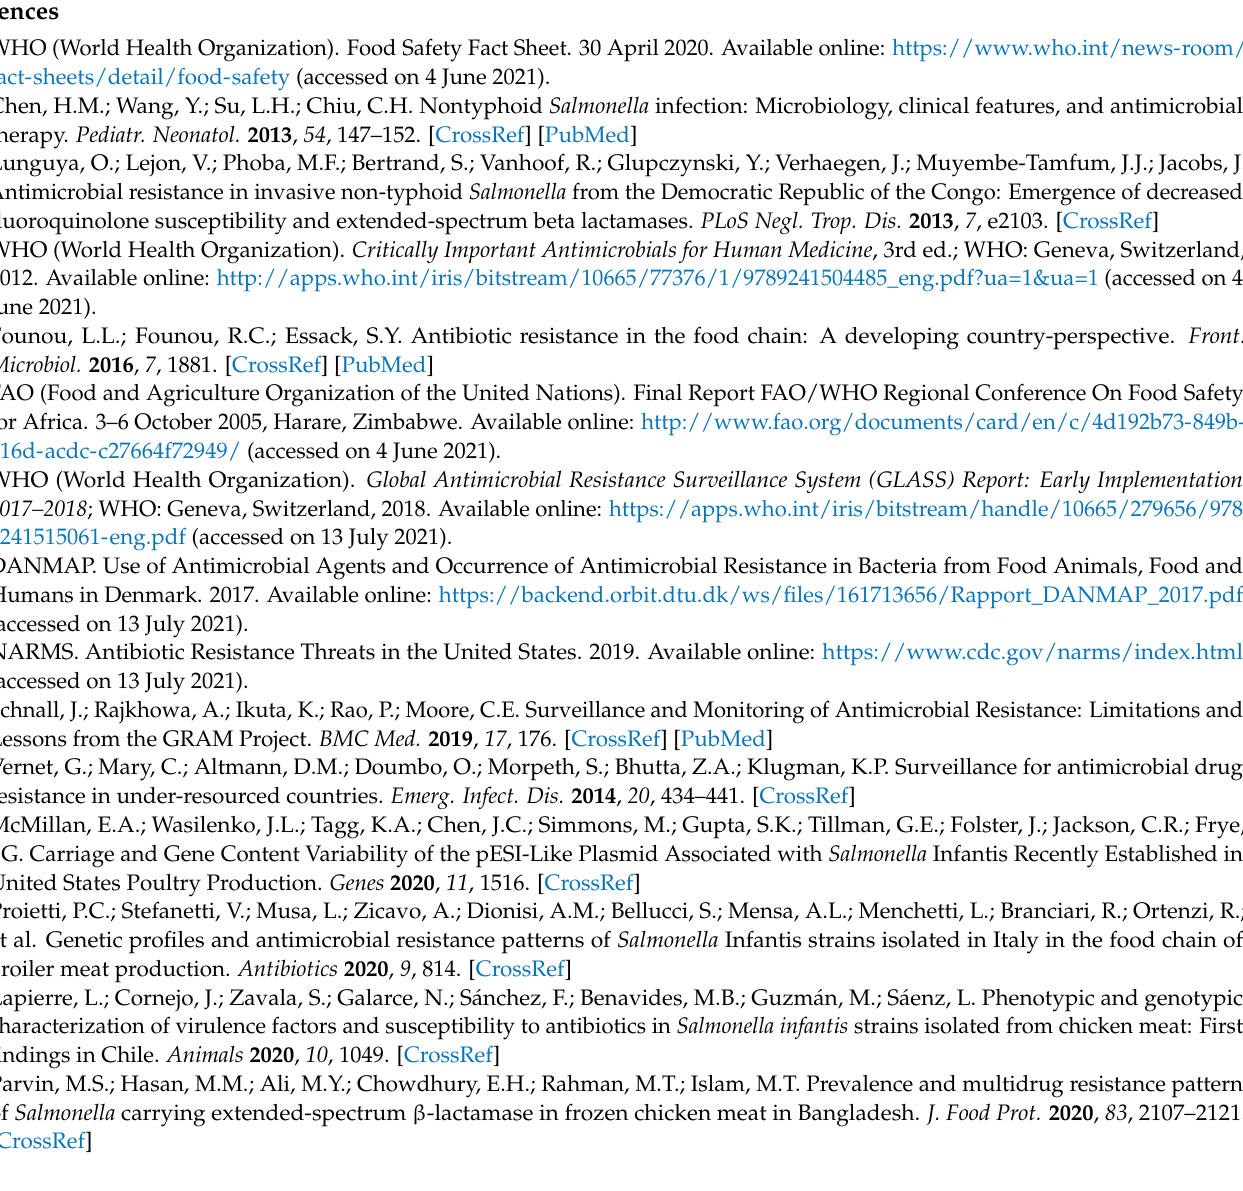
and slaughterhouses in 2010 and 2020 from Egypt. Table S5: Results of conjugation experiments and plasmid replicon typing for Salmonella enterica isolated from retail meats and beef carcasses in Egypt. Table S6: Numbers and sources of meat samples used in this study. Table S7: City names and numbers of meat samples collected from four governorates (Dakahlia, Damietta, Gharbia, and Kafr El-Sheikh) in Egypt. Table S8: Primers used for PCR and DNA